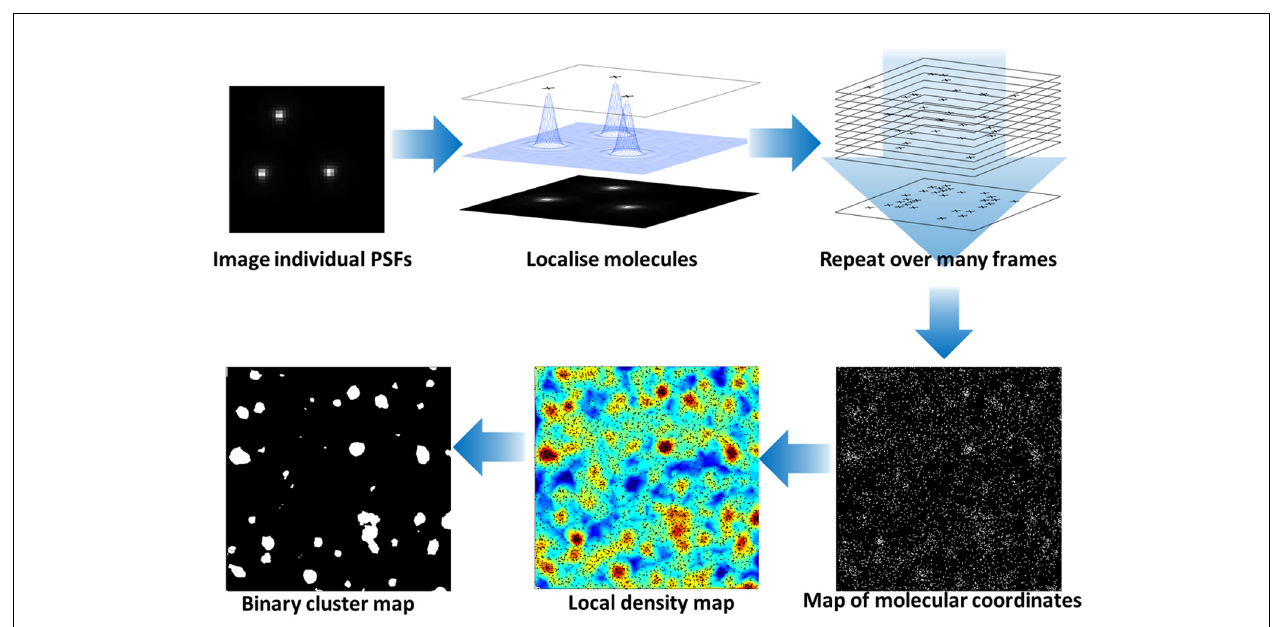
the appearance that molecules “blink” during the acquistion. Over successive frames, an image of all fluorescent molecular positions is built up. The molecular coordinates can be used to generate an image and be quantitatively analyzed to reveal the local density of fluorescent molecules (here based on Ripley K-function before and after application of a threshold) and hence clusters of proteins at the plasma membrane identified. For details on the cluster analysis, please see Williamson etal. (2011).